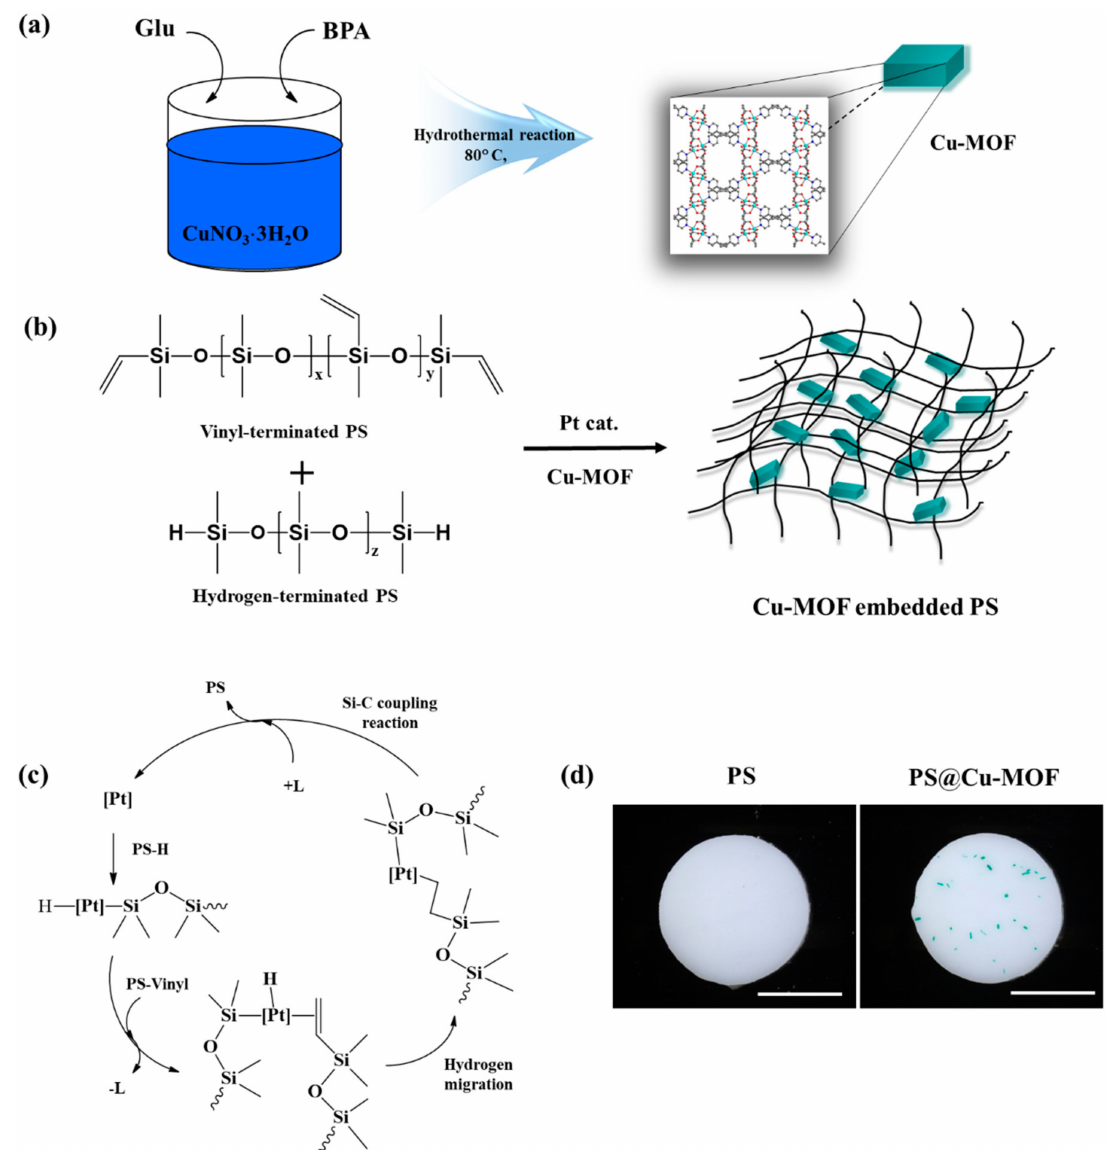
Figure 1. ( a ) Schematic illustration of the synthesis of Cu-MOF. ( b ) Hydrosilylation of vinyl-terminated PS and hydrogen- terminated PS with Cu-MOF in the presence of a Pt catalyst. ( c ) Curing mechanism for the hydrosilylation of PS-vinyl and PS-H containing a Pt catalyst. ( d ) Photographic images of PS and the PS@Cu-MOF. Scale bar: 0.5